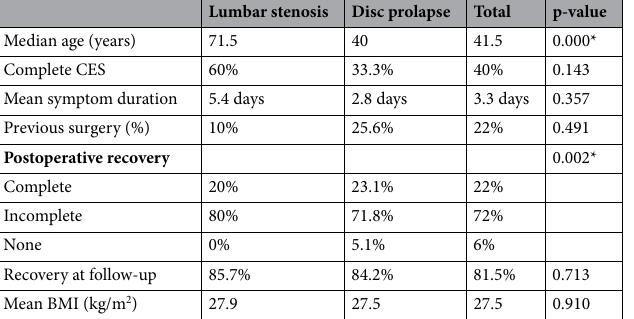
Lumbar stenosis Disc prolapse Total